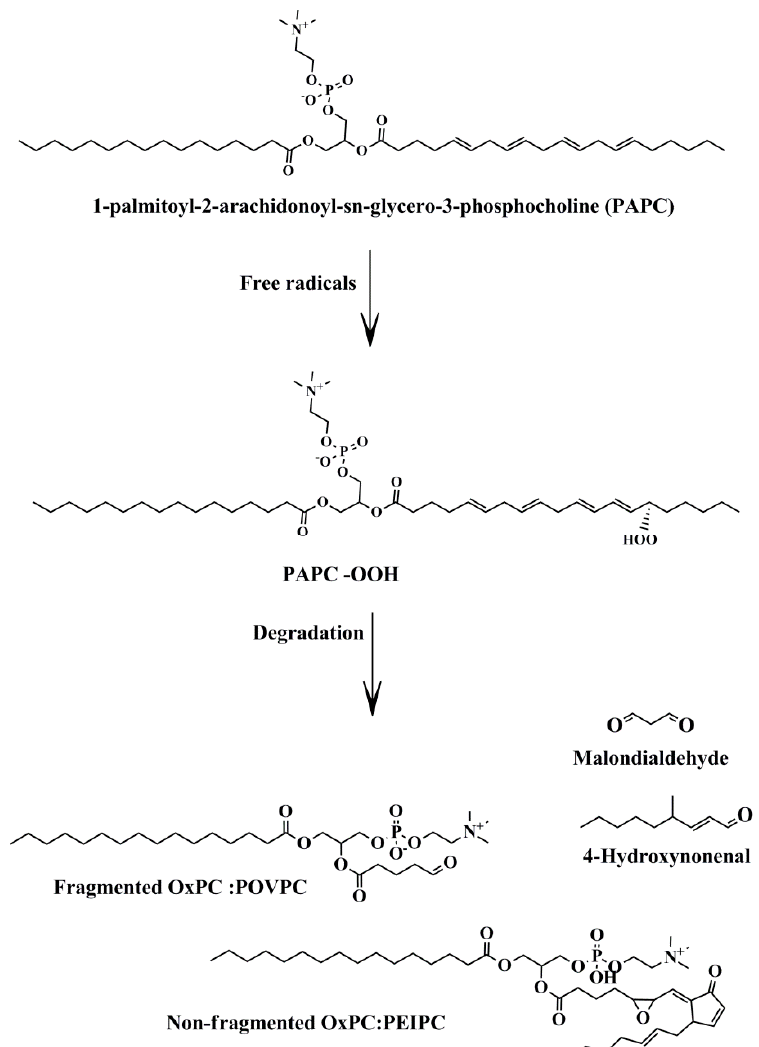
Figure 1. Non-enzymatic oxidation of membrane phospholipids. Free radicals may attack membrane phospholipids such as PAPC, leading to the production of bioactive lipid molecules. Abbreviations: PAPC-OOH, PAPC hydroproxide; OxPC, oxidized phosphatidylcholine; PEIPC, 1-palmitoyl-2-(5,6-epoxyisoprostane E2)-sn-glycero-3-phosphocholine.